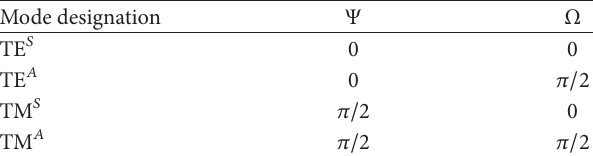
Table 3: Values of parameters Ψ and Ω for Table